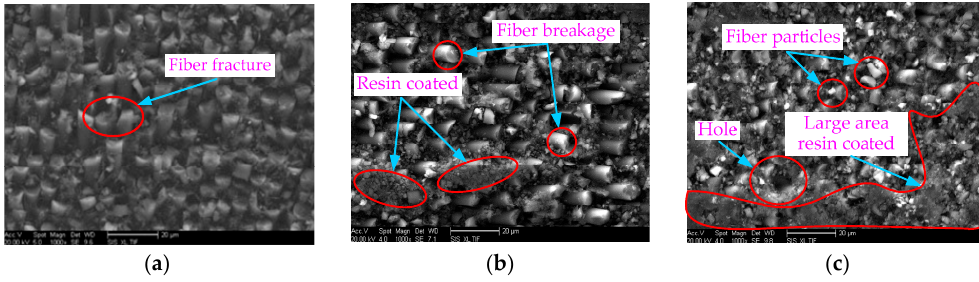
Figure 7. Surface SEM image of CFRP in various wear states: ( a ) L : 3 m, R max : 23 µm; ( b ) L : 51 m, R max : 61 µm; ( c ) L : 81 m, R max : 76 µm.